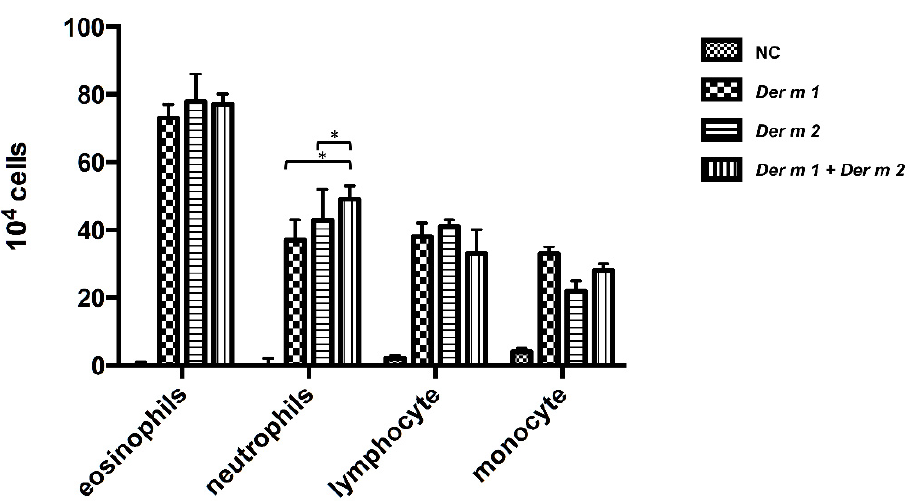
Figure 5. The infiltrating inflammatory cells in the BALF of sensitized mice. All inflammatory cell counts were obtained from the NC group and Der m 1 , Der m 2, or Der m 1 + Der m 2 sensitized/challenged mice. The inflammatory cells were counted ( × 10 4 ) from the BALF in millimeters by morphometric evaluations of cytospin preparations. * p < 0.05 compared with Der m 1 + Der m 2 .